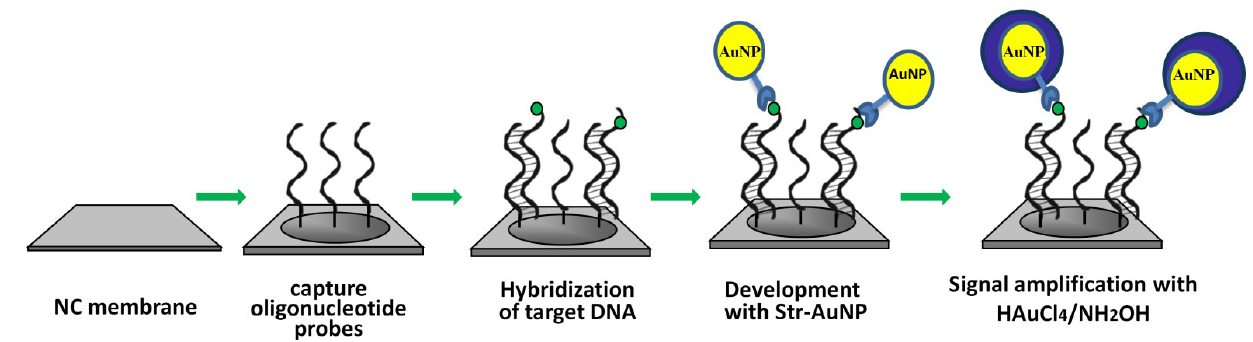
Figure 1. Scheme of successive stages of target oligonucleotide hybridization on membrane-based DNA-microarrays followed by seed-mediated growth of AuNP labels.